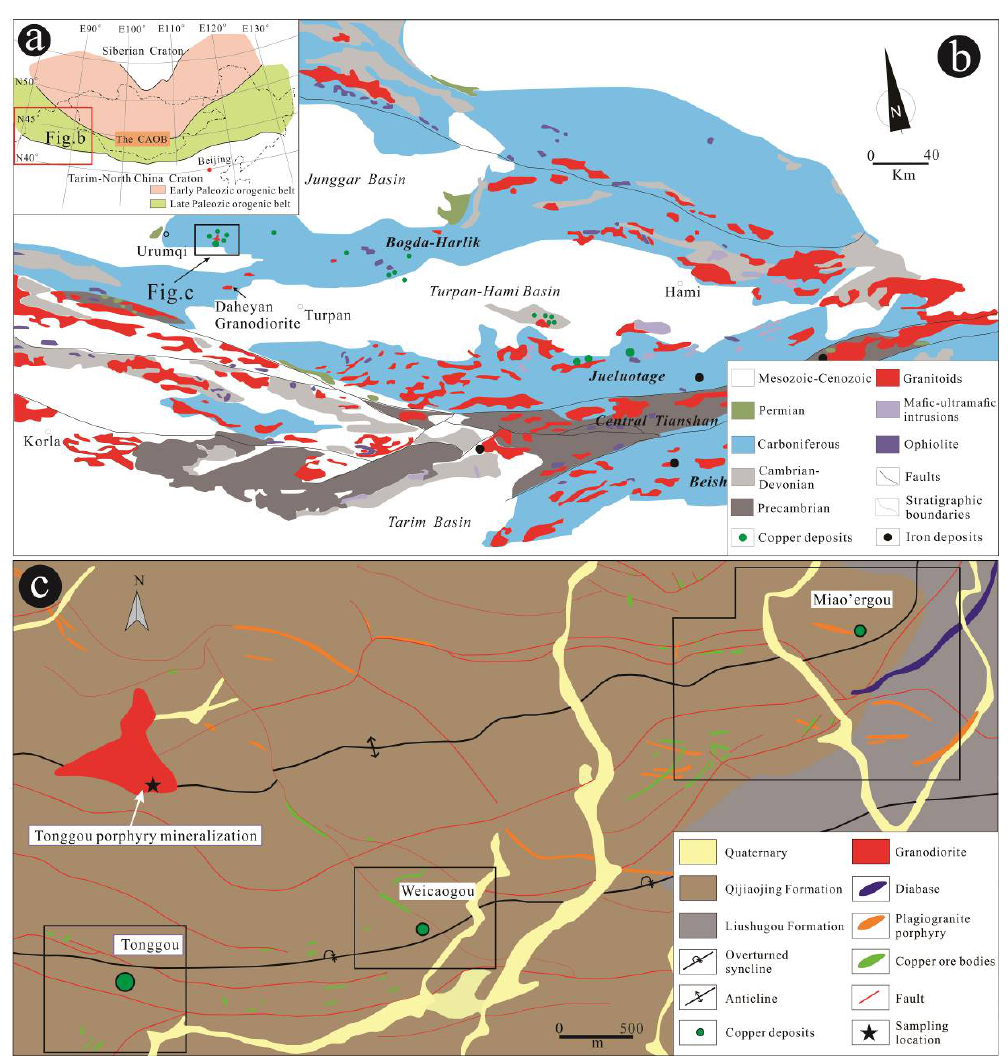
Figure 1. ( a ) Schematic geologic map of the Central Asian Orogenic Belt (CAOB); ( b ) geological map of Eastern Tianshan [ 38 ]; ( c ) geological map of the mineralized district in the Tonggou-Miao’ergou area [ 57 ].